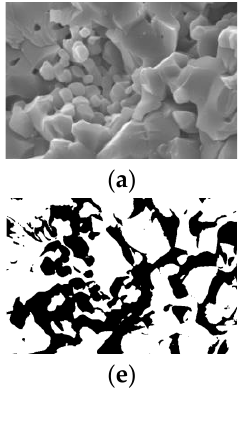
Figure 6. ( a ) SEM image of A2Y5 processed at 1815 °C at scale: 10 μ m; ( b ) image converted to binary; ( c ) detected edges (Find Edges tool) giving an FD = 1.729; ( d ) detected edges (CED plugin) giving an FD = 1.318; ( e ) image converted to binary with the median filter applied, ( f ) detected edges median filter applied, FE tool, FD = 1.405; ( g ) detected edges, median filter applied, CED plugin, FD = 1.269 (image looks fainter than ( d ) image).